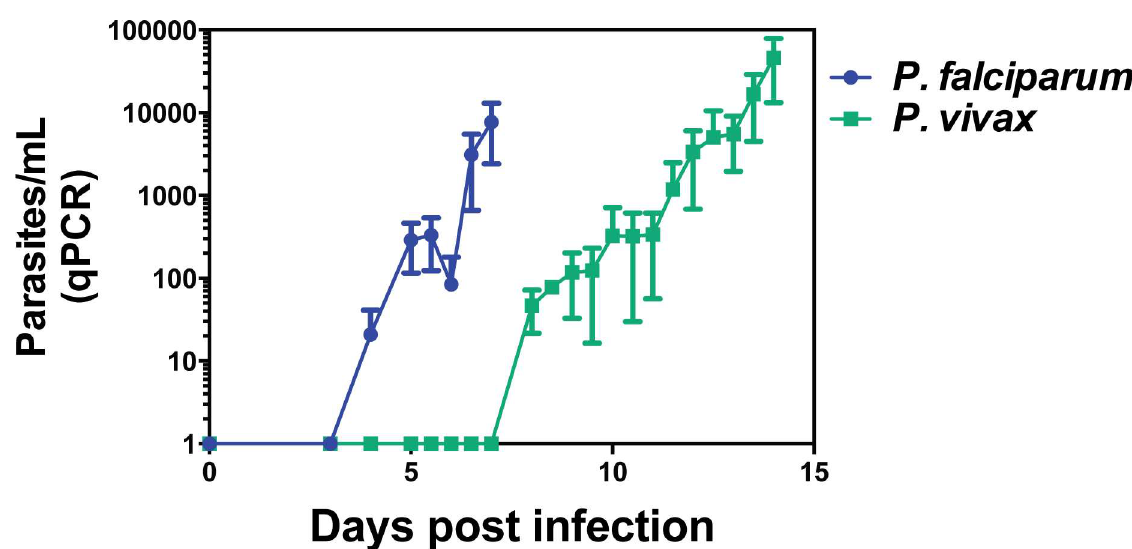
Fig 1. Kinetics of parasite levels during experimental blood-stage infection with P . falciparum or P . vivax . Malaria-naive volunteerswere infected intravenously at day 0 with freshly thawed cryopreserved P . falciparum or P . vivax infected erythrocytes. Parasite growth modelingusing in silico analysisestimated that the P . vivax infectingdose was 15 times lower comparedto the P . falciparum infecting dose ( Khoury D & McCarthy JS , in preparation) . Parasite levels in peripheral blood of infected volunteerswere determinedusing consensus Plasmodium species-specific qPCR as previously described[12]. Blood samplesused to assess immune responseswere collectedprior to infection. Graphs show mean data from 19 volunteers from three independentcohorts ( P . falciparum )and 8 volunteers from four independentcohorts ( P . vivax ); error bars indicateSD.